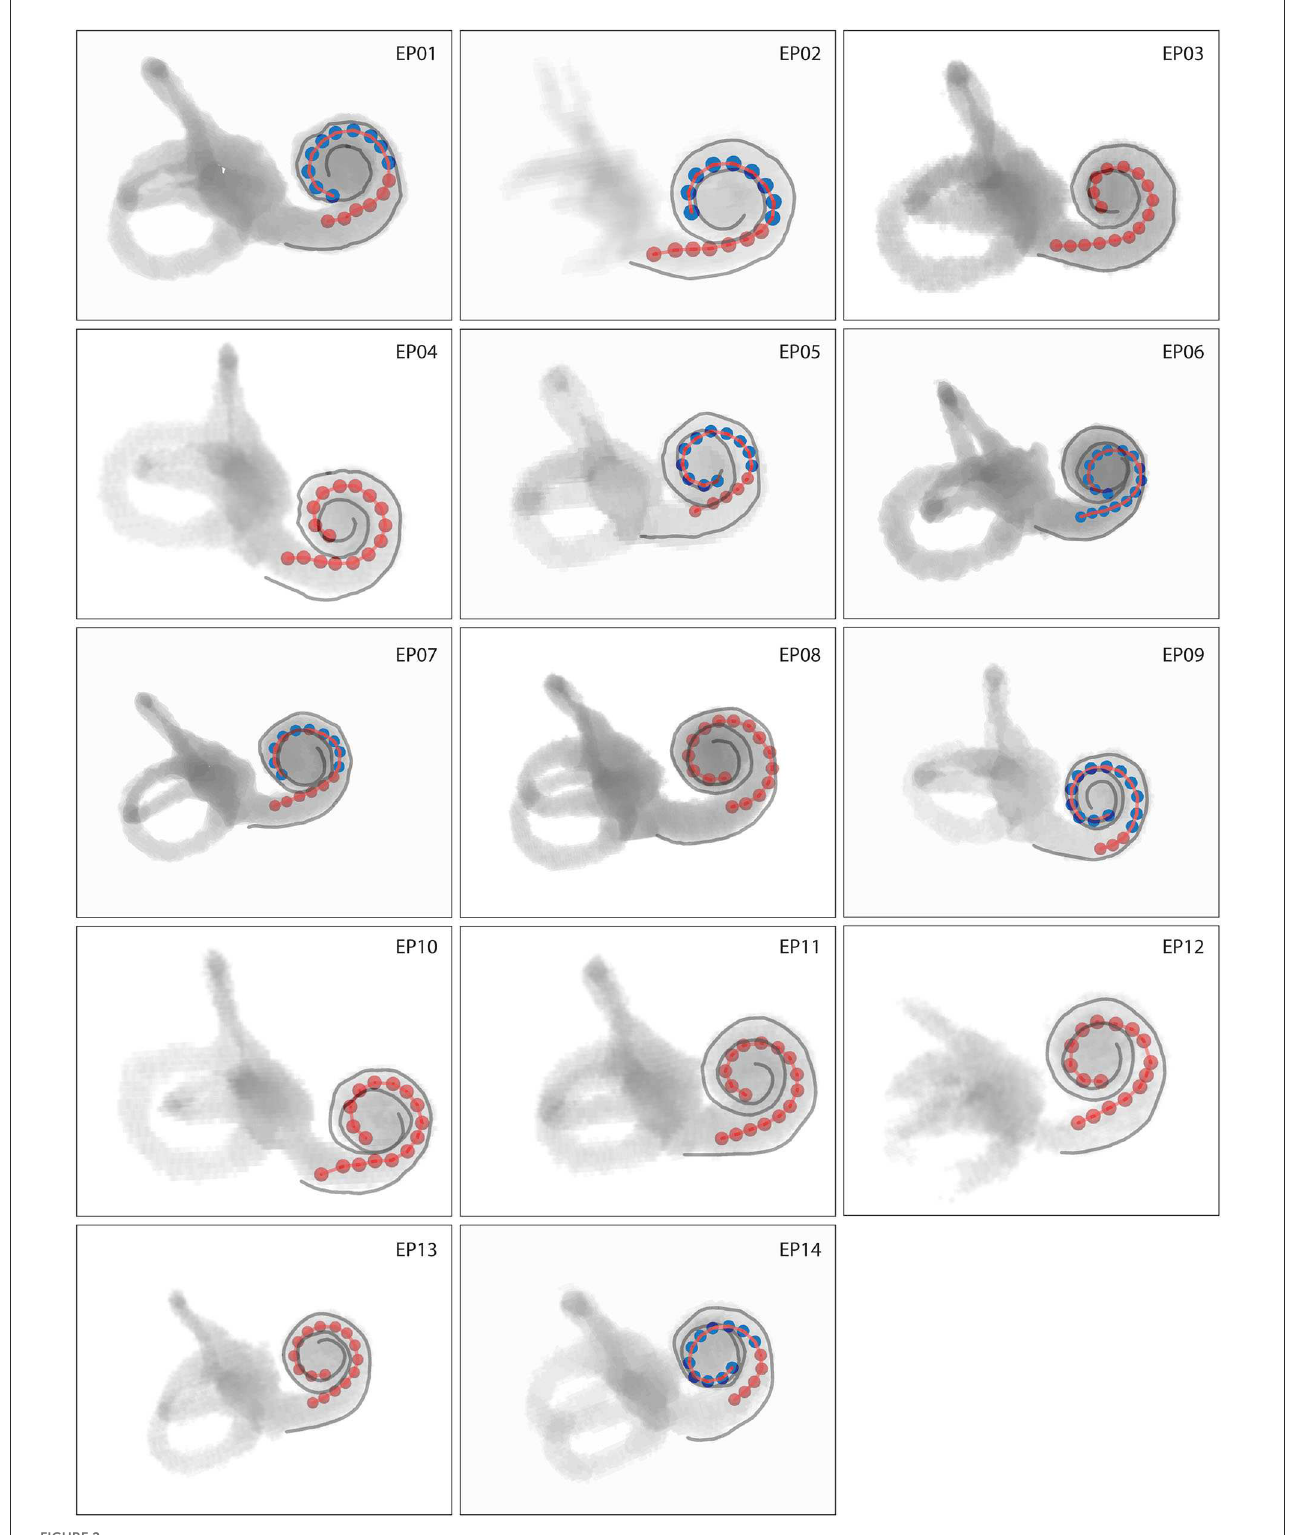
FIGURE2 Volume rendering of cochlear labyrinths where red markers represent individual electrodes and gray lines the lateral wall. Intracochlear scalar positions of electrodes are coded by color, with red electrodes located in scala tympani and blue electrodes located in scala vestibuli. Cochleas presented on the same scale show actual interindividual representations in